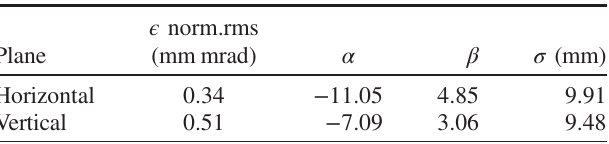
TABLE I. Twiss parameters from the input beam distribution of Fig. 12.